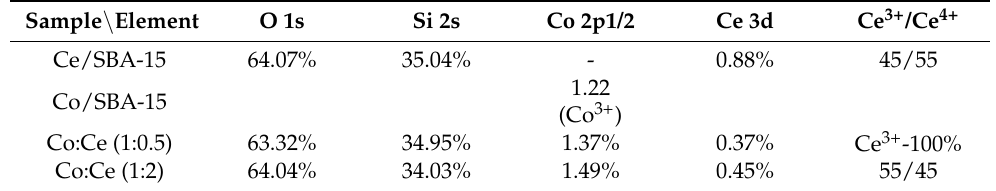
Table 2. Surface atomic concentrations (at. %) of Co 2+ , Co +3 , Ce +3 , and Ce +4